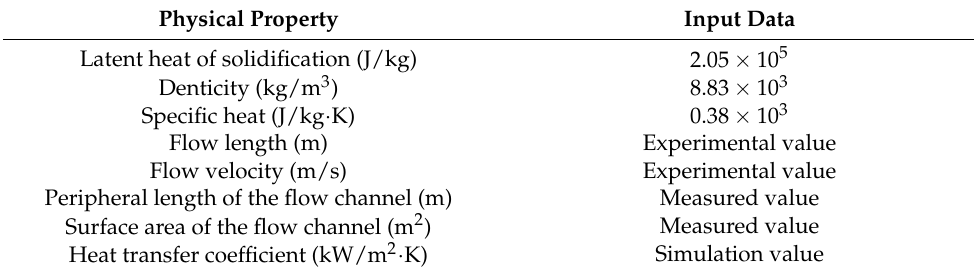
Table 5. Physical property data of Cu–8%Sn alloy (for calculation).